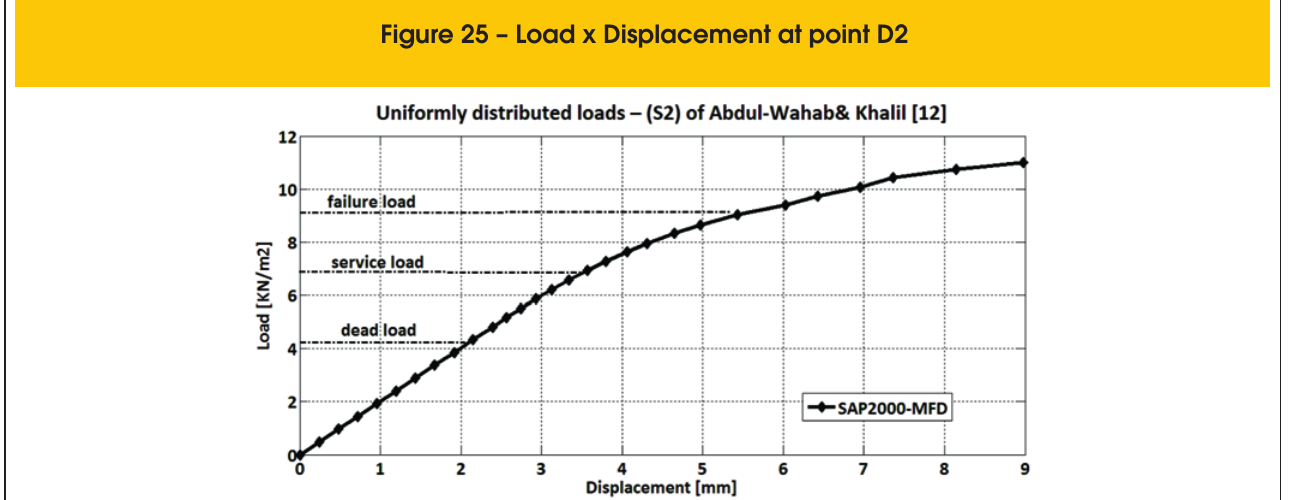
Figure 25 – Load x Displacement at point